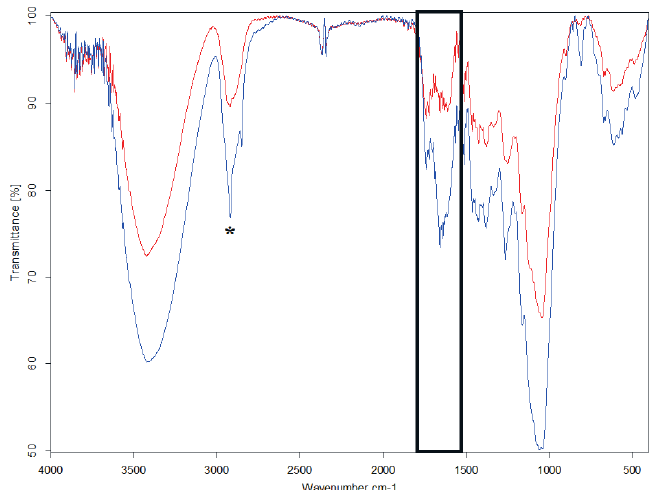
Figure 2. Overlay of infrared spectra comparing a raw hay sample (blue/bottom) to a charred hay sample (red/top). The boxed and starred areas show regions where the two spectra are distinctly different (see text).